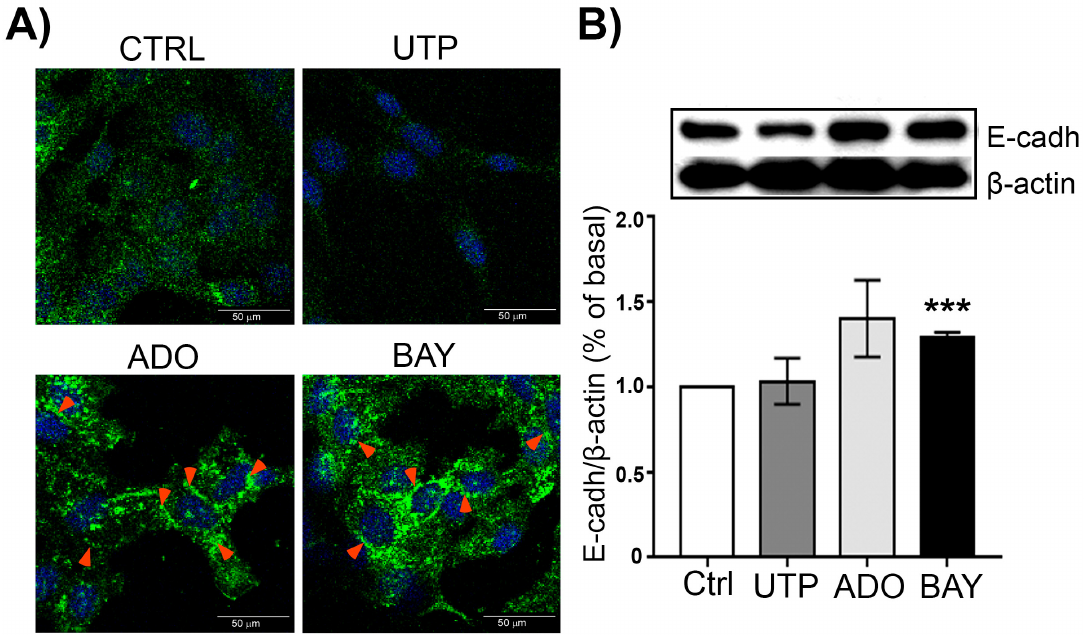
Figure 6. Stimulation of A2BR with BAY-606583 incremented the expression and induced the reloca- tion of E-cadherin. SKOV-3 cell cultures were stimulated for 16 h with 10 µ M BAY-606583, 10 µ M ADO or 100 µ M UTP. E-cadherin was detected by immunofluorescence ( A ) using a specific primary antibody and a secondary one coupled to AlexaFluor 488 (green signal). Nuclei were counterstained with DAPI (blue signal) and Western blot ( B ), where the abundance of E-cadherin was expressed in relation with against β -actin as housekeeping protein. In the graph, bars represent the mean ± S.E.M. of three independent experiments, *** p < 0.01 vs.